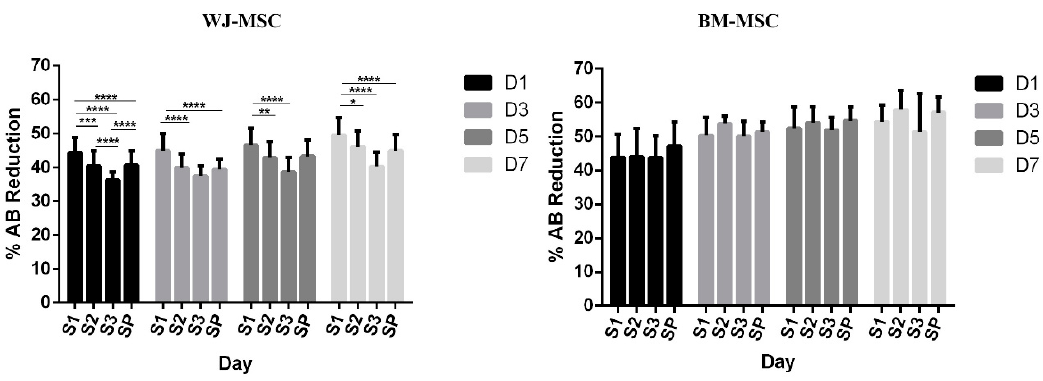
Figure 2. Metabolic activity of Wharton’s jelly mesenchymal stromal cells (WJ-MSCs, left) and bone